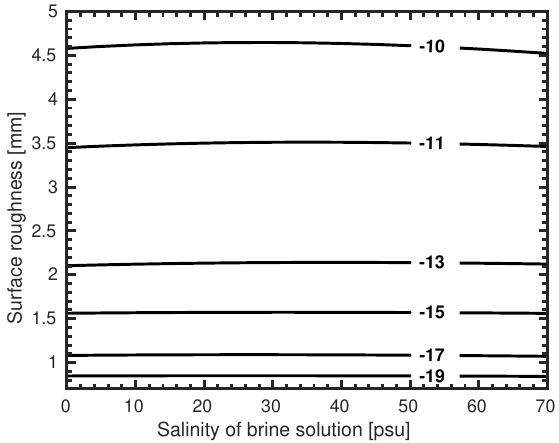
Figure 3. Contour plot in dB for C-band (5.405 GHz) VV-polarized σ 0 modelled using the IEM2Mc with incidence angle 39.2°. Surface correlation length is ten times RMS height ( l = 10 s ).